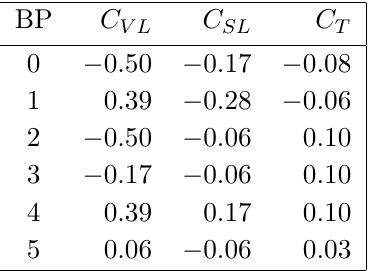
Table 1 . List of benchmark points for the distribution dBR( B ! D 0 (cid:3) (cid:28)(cid:23) ) = d(cos( (cid:18) (cid:28) )) obtained from the clustering procedure given in terms of the left-handed vector, scalar and tensor Wilson coe(cid:14)cients C V L ; C SL and C T .